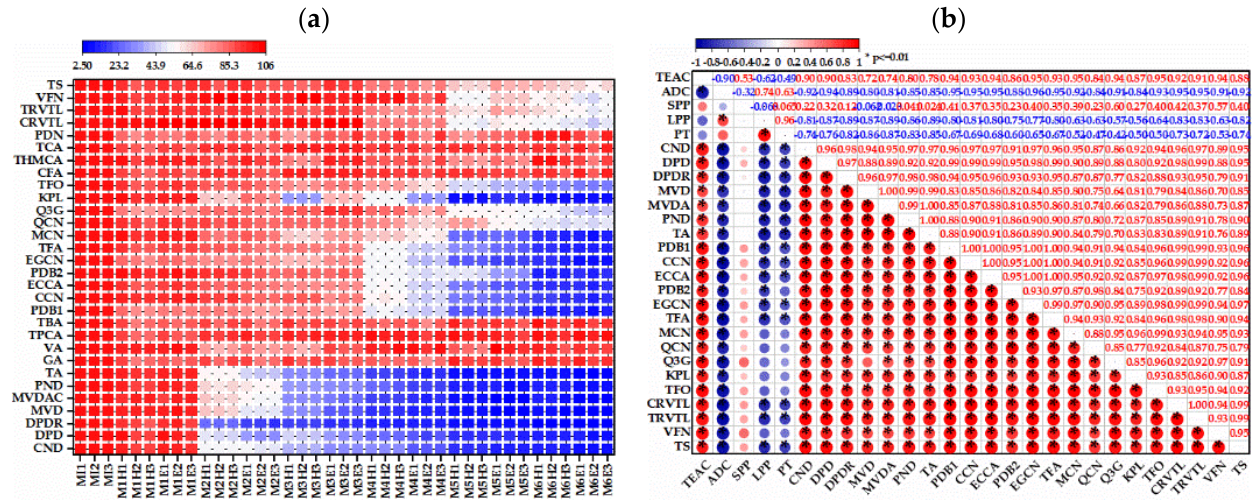
Figure 3. The percentage of initial concentration of each phenolics at different time points during wine aging ( a ) and the correlation of antioxidant activities and key phenolic compounds ( b ). For ( b ), red and blue colors represent positive and negative correlation, respectively; the large and small circular sizes correspond to strong and weak correlations, respectively; * denote statistical significance by Pearson’s correlation analysis at 0.01. Abbreviations: MI1, MI2 and MI3, three bottles of initial wine without exogenous acetaldehyde at 0 days; MiE1, MiE2 and MiE3 (i = 1, 2, 3, 4, 5, 6), three bottles of wine with different initial acetaldehyde (1–6) at 30 days of aging; MiH1, MiH2 and MiH3 (i = 1, 2, 3, 4, 5, 6), three bottles of wine with different initial acetaldehyde (1–6) at 75 days of aging; TEAC, antioxidant activities were expressed as Trolox equivalents per liter of wine (mM TEAC/L); ADC, acetaldehyde consumption; TA, total anthocyanins; TFA, total flavanols; TFO, total flavonols; SPP, short polymeric pigments; LPP, large polymeric pigments; PT, polymeric tannins; CND, cyanidin-3-glucoside; DPD, delphinidin-3-glucoside; DPDR, delphindin 3-O rutinoside; MVD, malvidin-3-glucoside; MVDAC, malvidin-3-glucoside acetate; PND, peonidin-3-glucoside; GA, gallic acid; VA, vanillic acid; TPCA, trans-p-coumaric acid; TBA, total benzoic acid; PDB1, procyanidin b1; CCN, catechin; ECCA, epicatechin; PDB2, procyanidin b2; EGCN, epigallocatechin; MCN, myricetin; QCN, quercetin; KPL, kaempferol; CFA, caffeic acid; THMCA, trans-ferulic acid; TCA, total hydroxycinnamic acid; PDN, polydatin; CRVTL, cis-resveratrol; TRVTL, trans-resveratrol; VFN, viniferin; TS, total stilbenes.